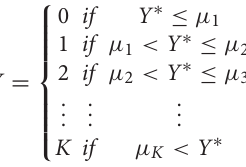
Table 2 summarized the model fitting results for each